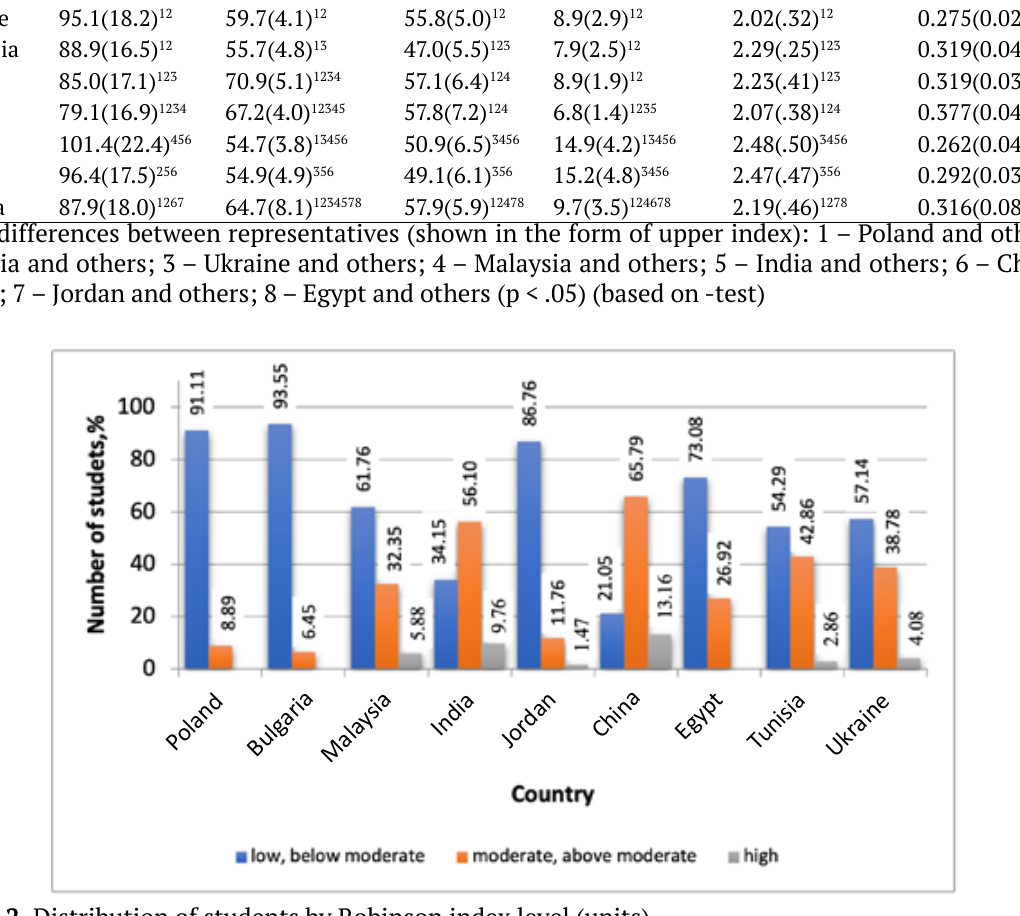
Figure 2. Distribution of students by Robinson index level